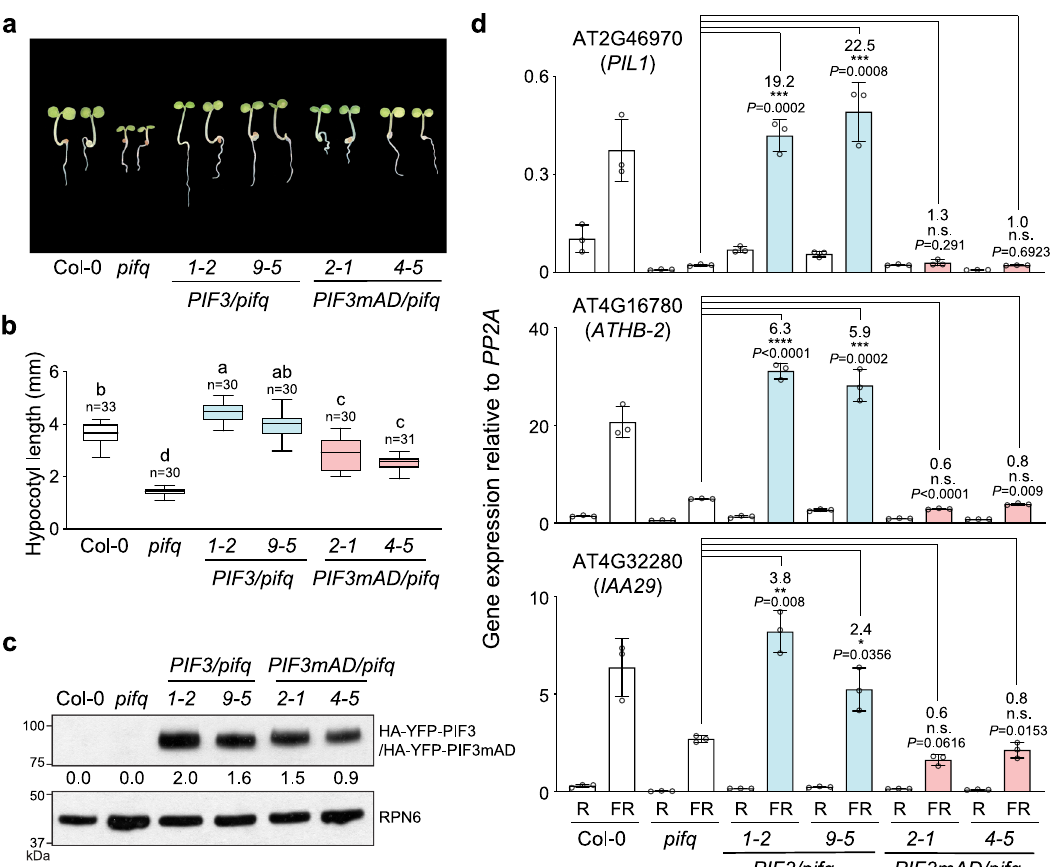
Fig. 6 PIF3 ’ s AD participates in gene activation by shade. a Images of representative 4-d-old seedlings of Col-0, pifq , two PIF3/pifq lines, and two